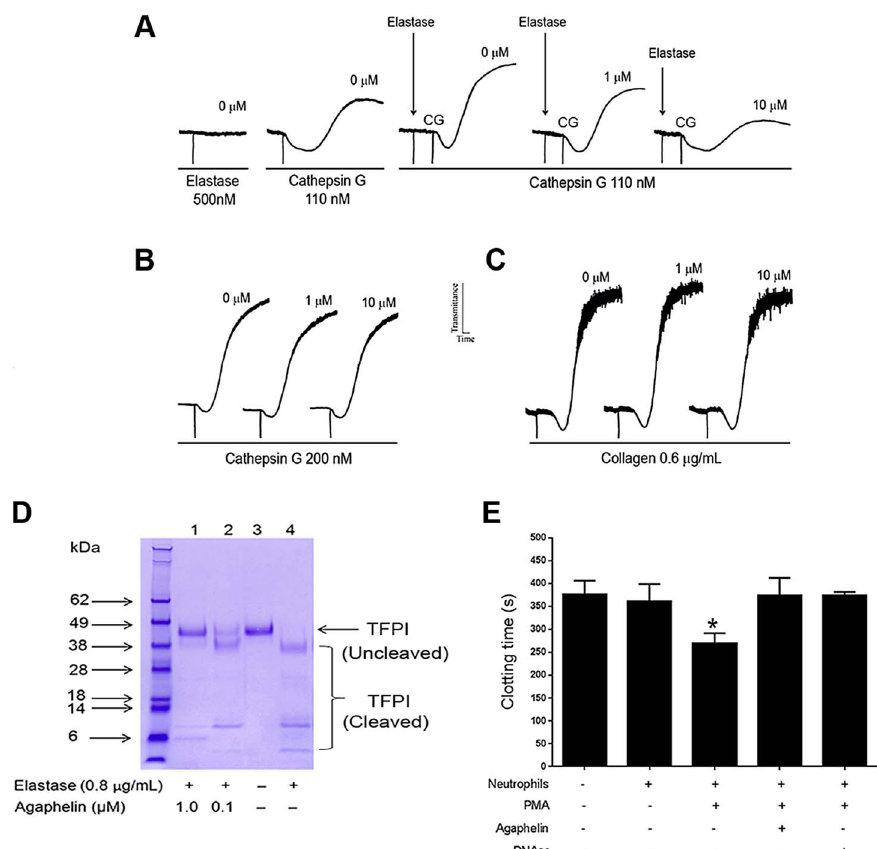
Figure 4. Agaphelin inhibits elastase-mediated platelet aggregation, TFPI-cleavage by elastase, and neutrophil-induced coagulation. A) Platelet aggregation. Washed human platelets were stimulated with elastase only (500 nM, left panel), or cathepsin G only (110 nM, middle tracing), or elastase followed by cathepsin G (right tracing). In some experiments, Agaphelin (1 or 10 m M) was added to platelets followed by addition of elastase for 1 min, and cathepsin G. B) Agaphelin does not inhibit cathepsin G (200 nM) or C) collagen (0.6 m g/ml)-induced platelet aggregation. Aggregation response was monitored by turbidimetry using a Lumi-Aggregometer. D) TFPI cleavage. Agaphelin (0.1 m M and 1 m M) was incubated with 1 m g of TFPI in the presence of PBS or human neutrophil elastase (0.8 m g/ml). After 2 h, reactions were stopped by addition of LDS loading buffer (under reducing conditions, 10 mM DTT), boiled for 5 min, and loaded in 4–12% Nu-PAGE gel. Gels were Coomassie Blue- stained. E) Neutrophil-induced coagulation. Neutrophils (5 6 10 5 cells/well) were incubated with Agaphelin (1 m M), PBS (control) or DNAse (Dornase alfa, 4 m g/ml) for 1 hour, followed by addition of PMA (50 nM) for 3 hrs. Fifty m l of this suspension was added to 50 m l of plasma, and reactions were started by addition of CaCl 2 (12.5 mM, final concentration)(*, p ,